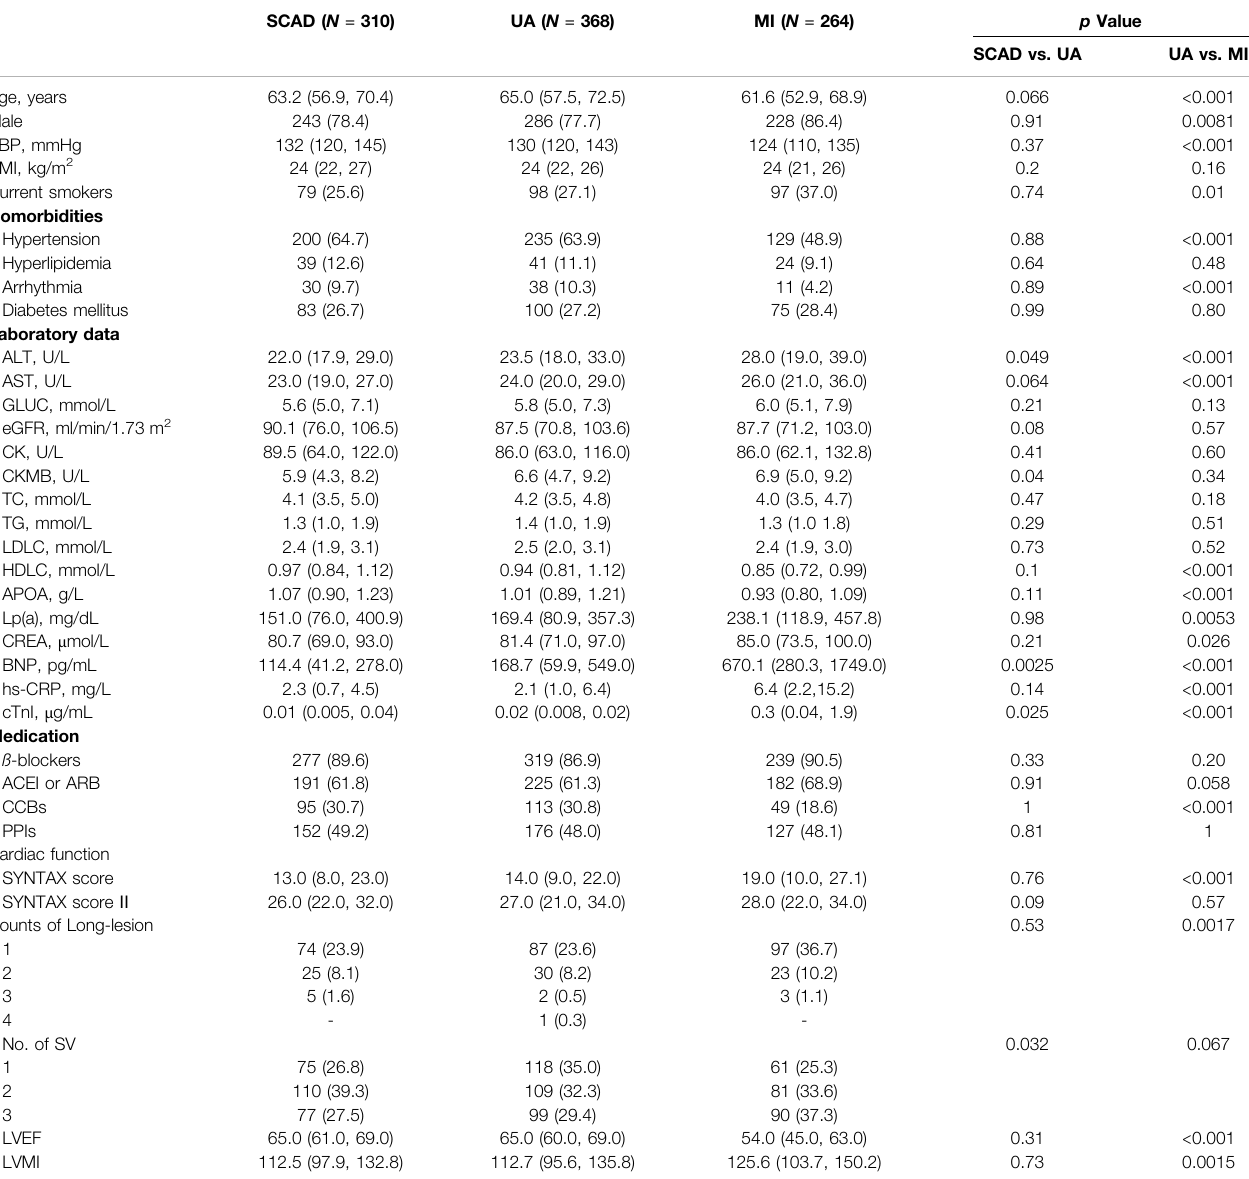
TABLE 1 | Baseline characteristics of discovery